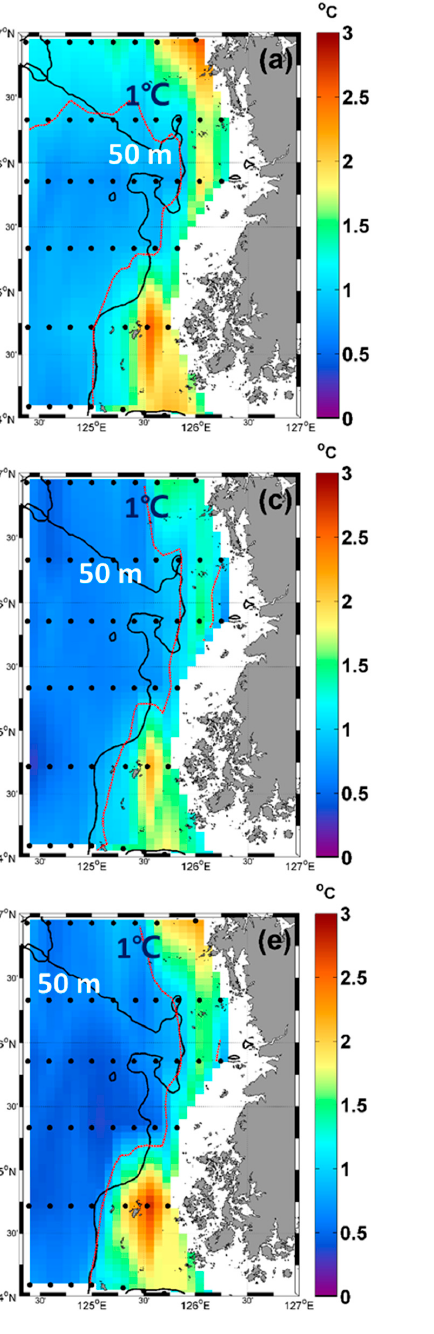
Figure 4. Horizontal distribution of the RMSD (°C) between the global gridded SST and the in situ CTD SST: ( a ) OISST ( b ) MGDSST, ( c ) OSTIA, ( d ) MWIR, and ( e ) GMPE. The black contour represents the 50-m isobath. The red contour is plotted along the 1°C RMSD. ( f ) Four-year mean distribution of the CTD SST in June. The contour interval for the surface temperature in ( f ) is 1 °C.